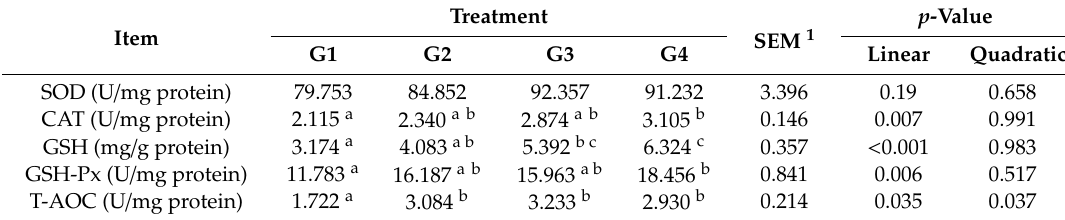
Table 4. E ff ect of Gln on antioxidant of the breast muscle in heat-stressed Table 4. Effect of Gln on antioxidant of the breast muscle in heat-stressed broilers.